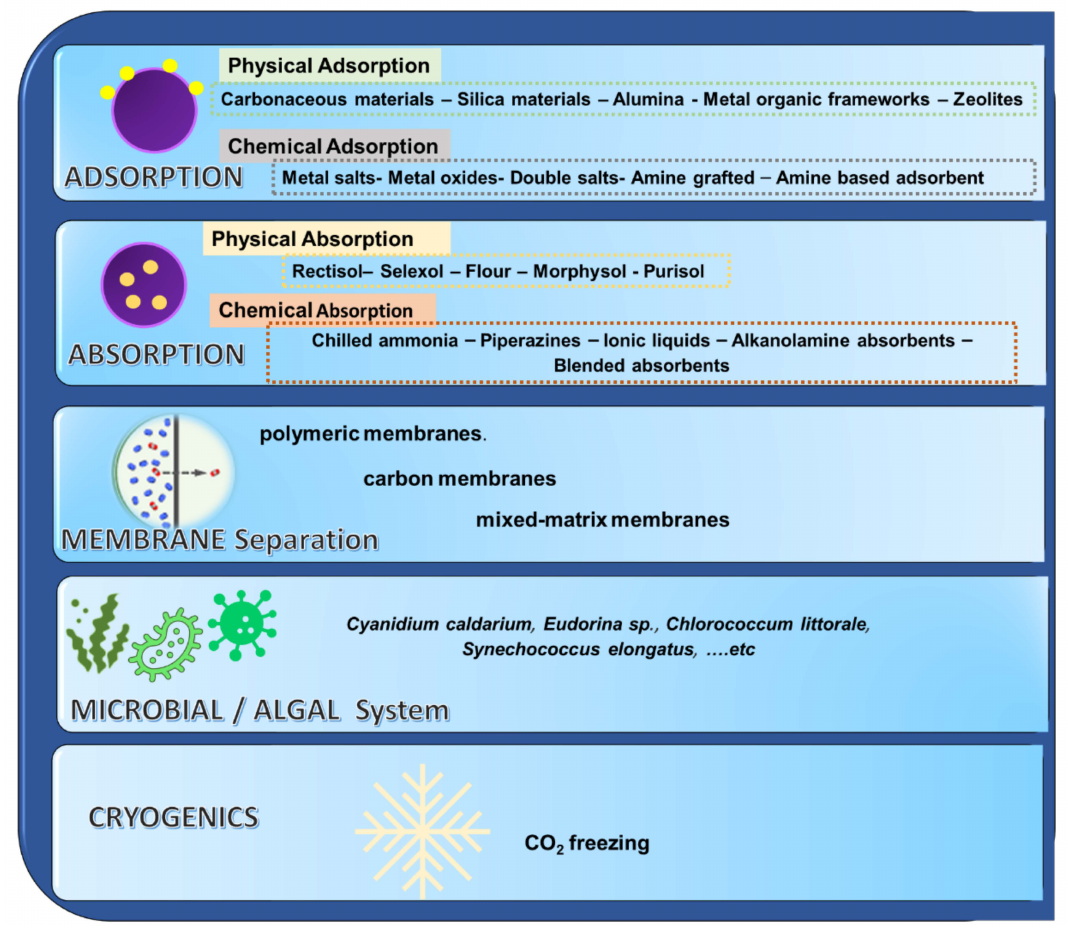
Figure 4. Post‑combustion capture